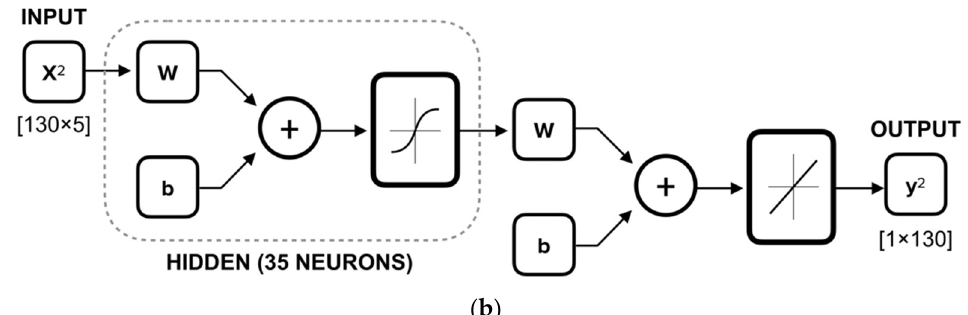
Figure 10. Defined architecture for the two networks: ( a ) ANN1 and ( b ) ANN2.